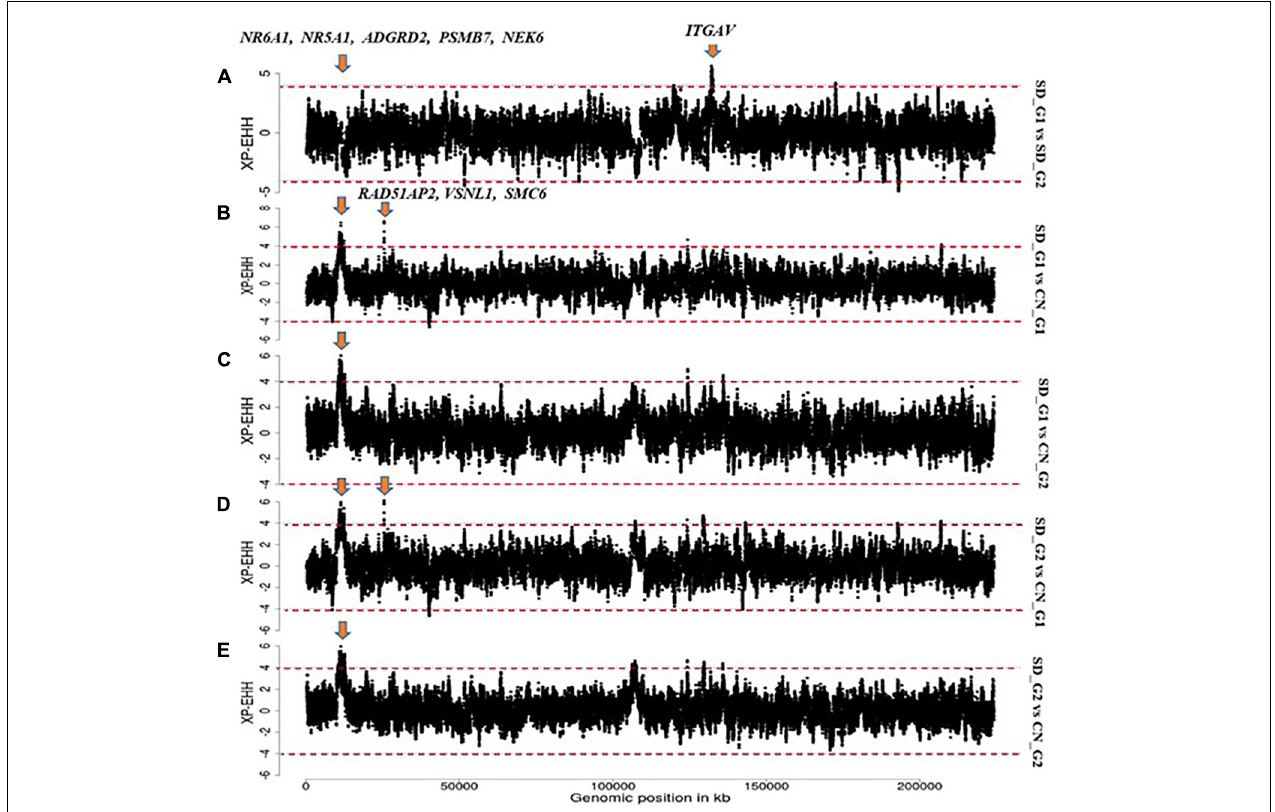
FIGURE 9 | Manhattan plots showing the strongest candidate signatures of selection as determined with XP-EHH on OAR3. (A) SD_G1 vs. SD_G2; (B) SD_G1 vs. CN_G1; (C) SD_G1 vs. CN_G2; (D) SD_G2 vs. CN_G1; (E) SD_G2 vs.